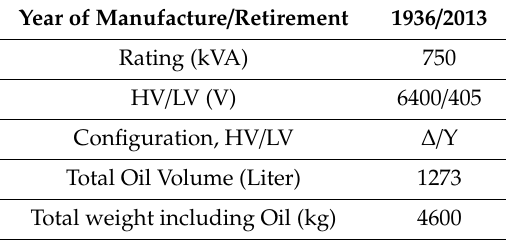
Table 1. Details of transformer under test.